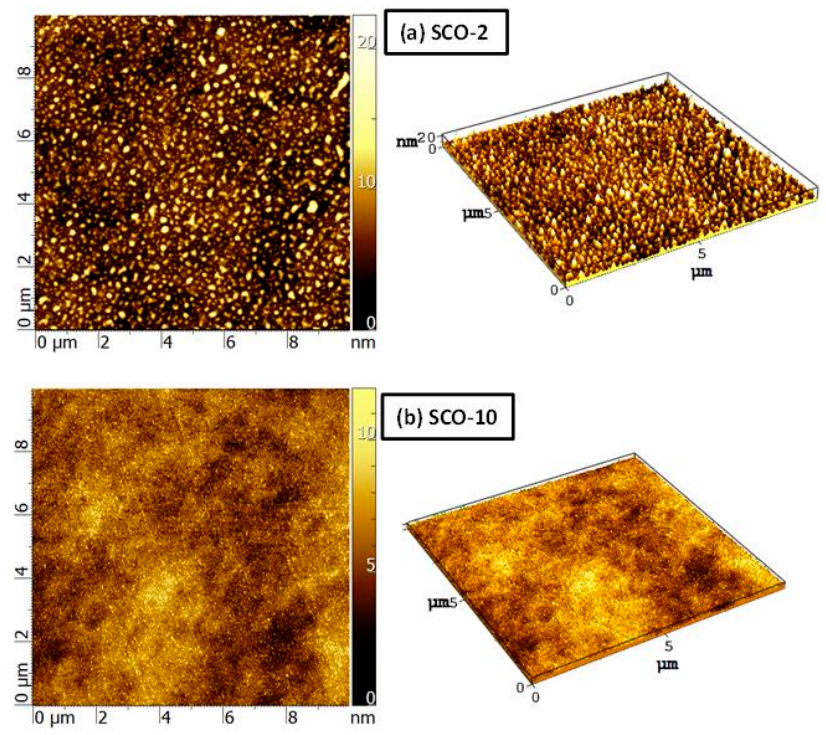
Figure 11. AFM images of the SCO-2 ( a ) and SCO-10 ( b ) samples.